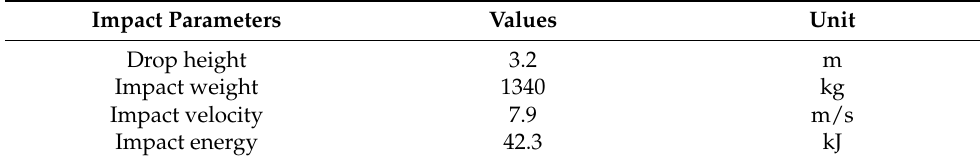
Table 3. Information of falling weight impact test.